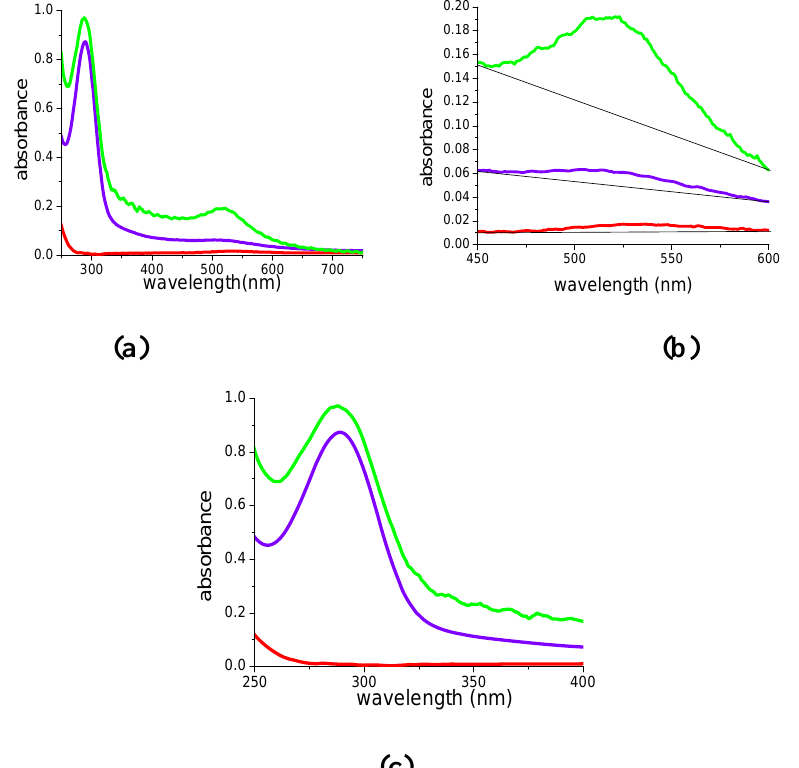
Figure 1. (a) UV-Vis spectra of PAMAM G5-capped suspensions of AuNPs produced for 16 min, with 5 mJ pulses at 1064 nm (red curve), 532 nm (green curve) and 355 nm (violet curve). Optical Path length OPL = 2mm. (b) and (c) : magnification in the plasmon and UV regions,